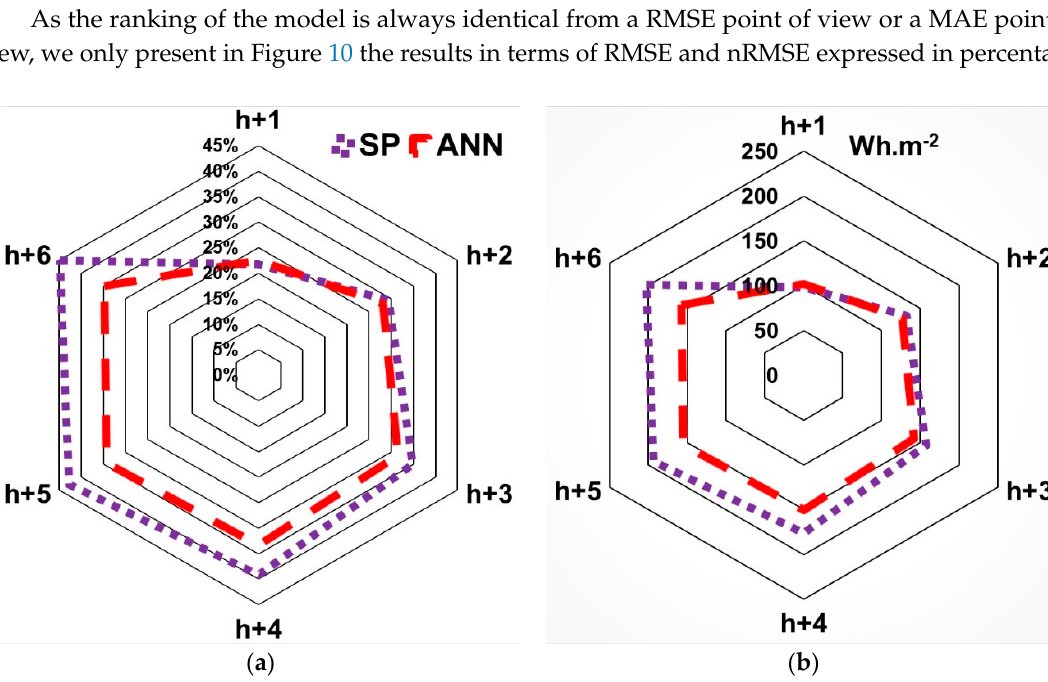
Table 7. Performance metrics (in Wh/m² for RMSE, MAE, and MBE) for DNI (in bold is the best predictor for each horizon and each error metric) (Odeillo site).